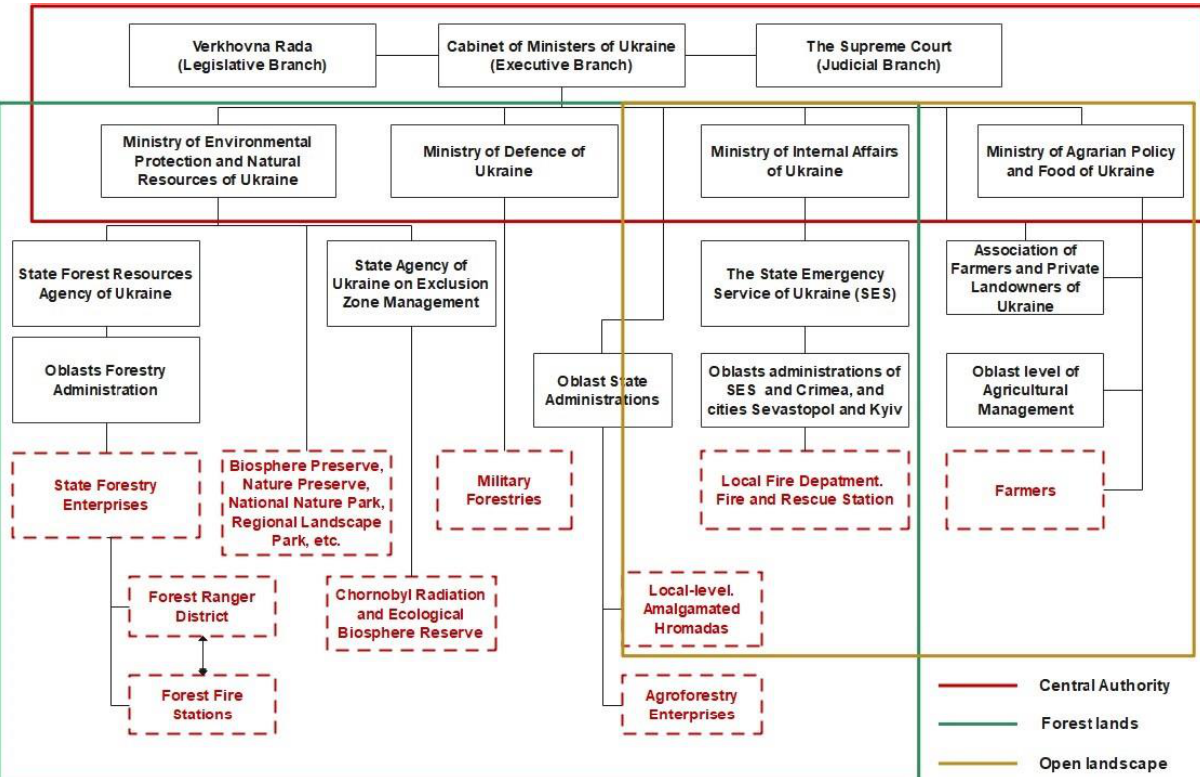
Fig. 4. Departmental Organization of protecting natural and cultural landscapes in Ukraine from